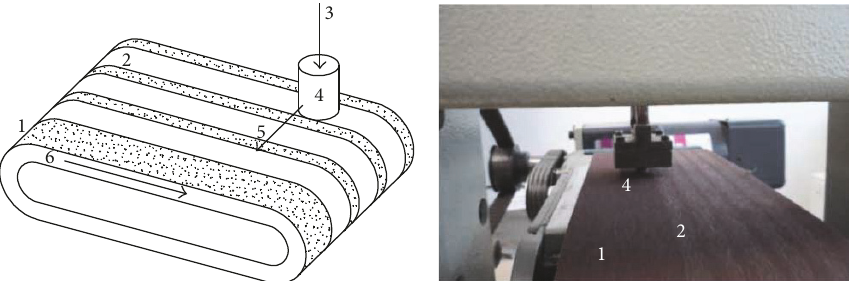
Figure 1: Schematics of the test setup (1) abrasive paper; (2) wear track; (3) normal force ( 𝐹 𝑁 ); (4) polymer pin; (5) cross-feed; (6) sliding direction.